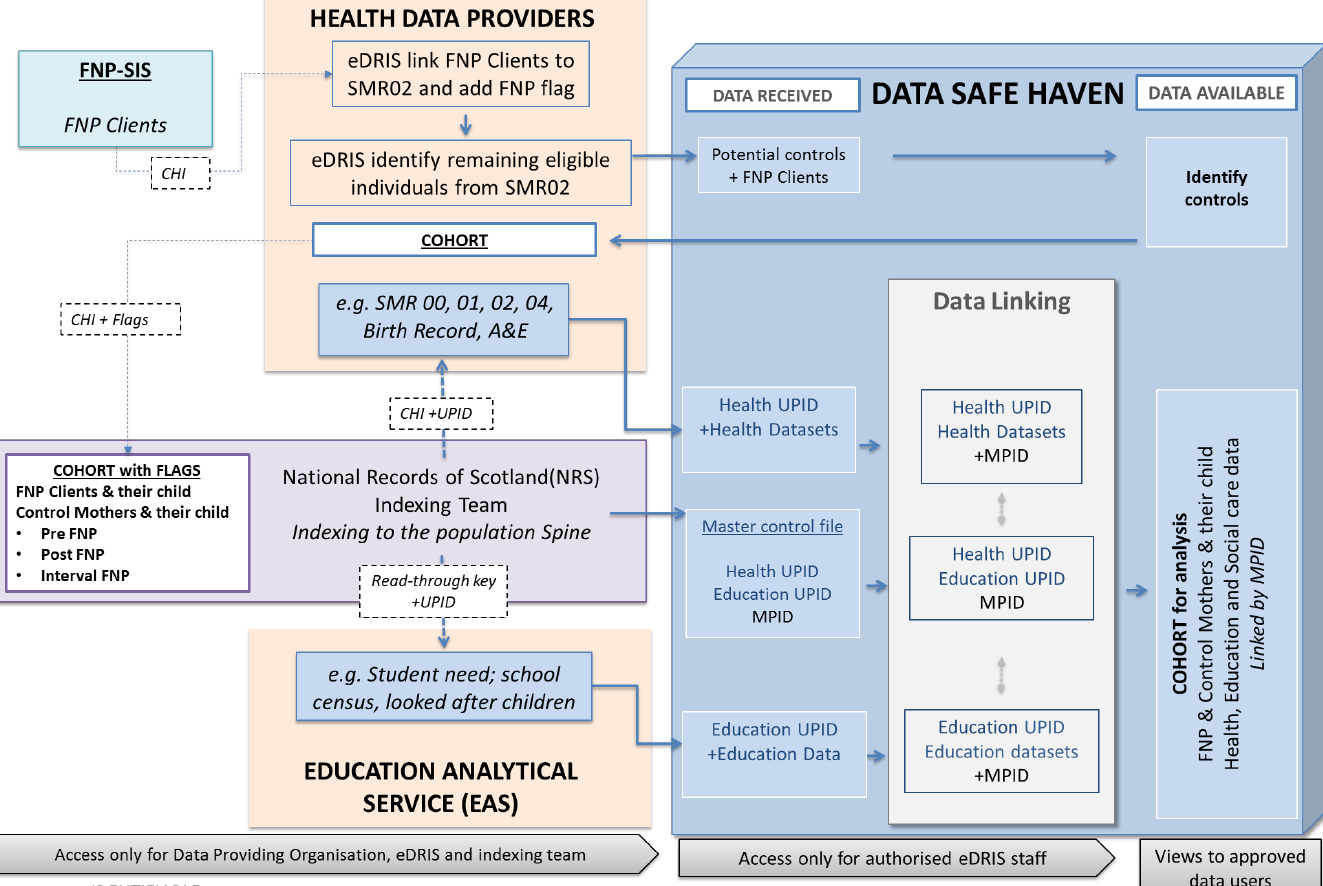
Figure 1: Model of pseudonymised data linkage: FNP Scotland Research